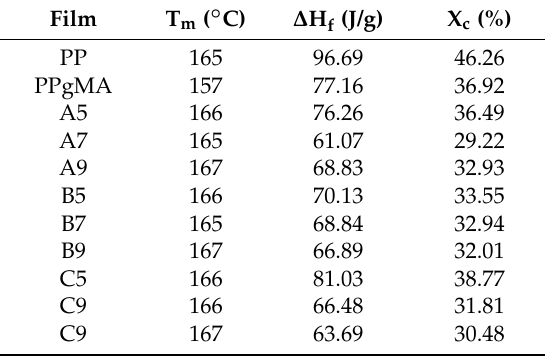
Table 2. Melting temperature (T m ), fusion enthalpy ( ∆ H f ), and crystallinity degree (X c ) of films of PP and